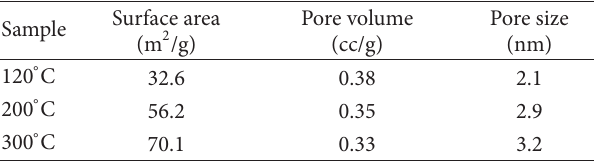
T 2: BET results for the MPTS-based TiO annealed at the different temperatures.